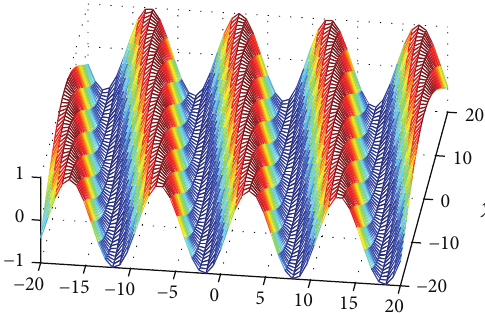
Figure 1: One period wave solution to (17) with the parameters 𝑘 = 0.1 , 𝑝 = 1 , 𝑡 = 0.5 , 𝜏 = 2𝑖 , 𝑐(0.5) = 30 , 𝑏(0.5) = 1 , and ℎ(0.5) = 1 .